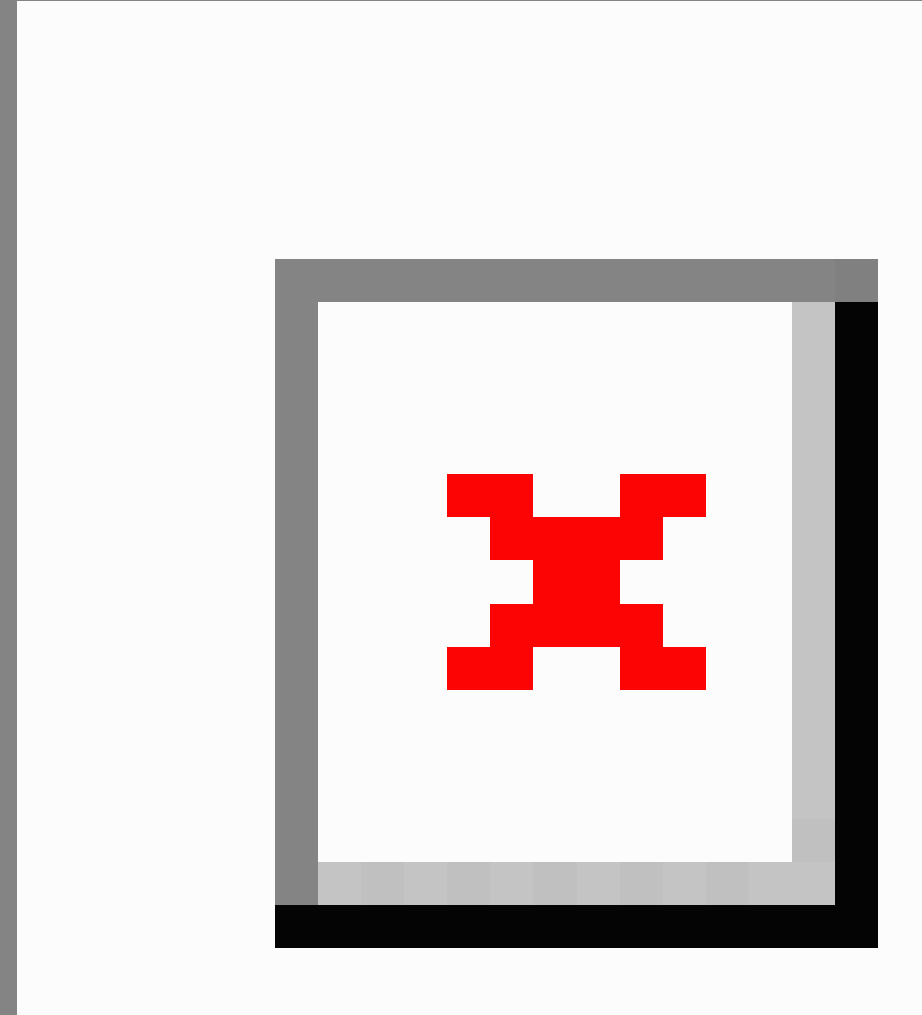
Figure 3. Screenshot of MoodGYM